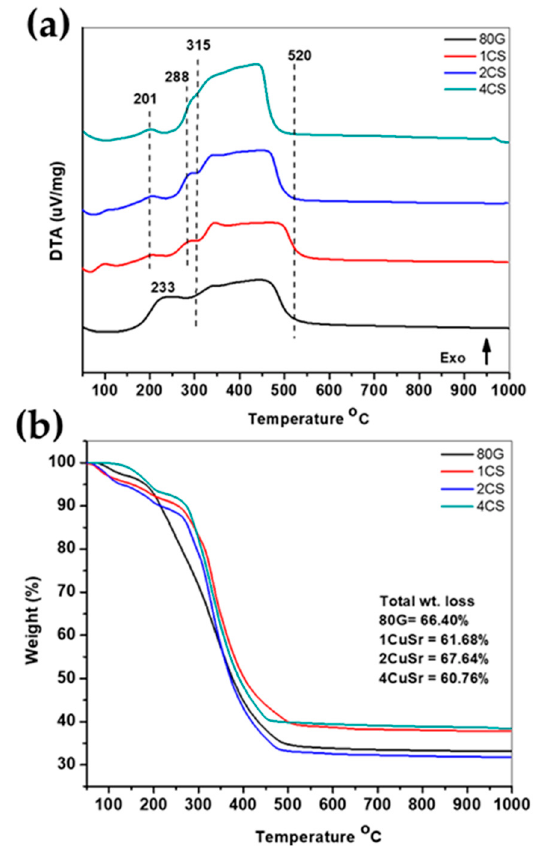
Figure 1. DTA ( a ) and TGA ( b ) plots of as-prepared base glass (80G) and co-doped CS-MBG (1CS, 2CS, 4CS) powders.